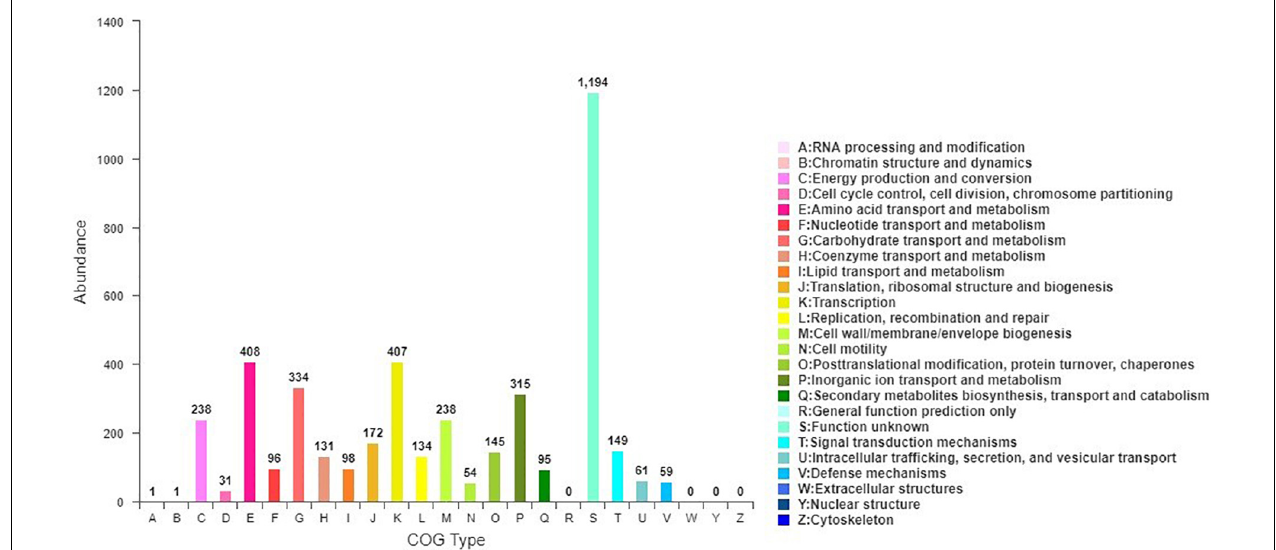
FIGURE 4 | Clustering of orthologous genes (COG) of predicted genes in JW-CZ2 genome.